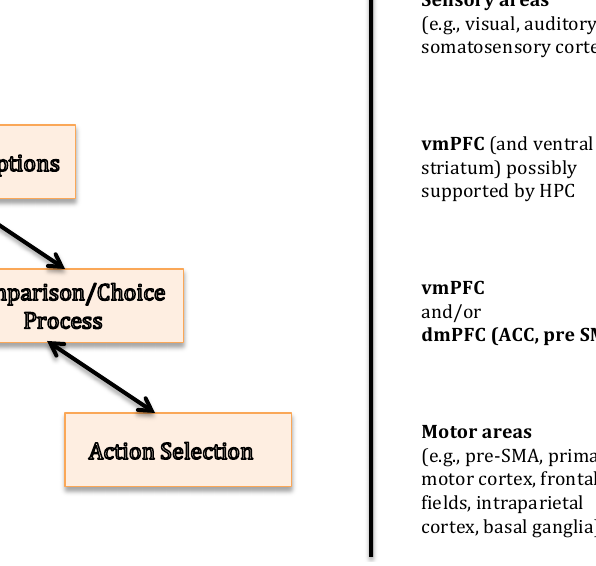
Figure 4. Value-based decision making in the human brain. The central features of a value-based decision are outlined on the left ; associated brain regions are listed on the right . The bidirectional arrows between valuation and choice as well as choice and action selection indicate that these mechanisms are not processed in a strictly serial and independent manner and may even be computed within a single brain region. vmPFC = ventromedial prefrontal cortex, dmPFC = dorsomedial prefrontal cortex, ACC = anterior cingulate cortex, HPC = hippocampus, pre-SMA = pre-supplementary motor